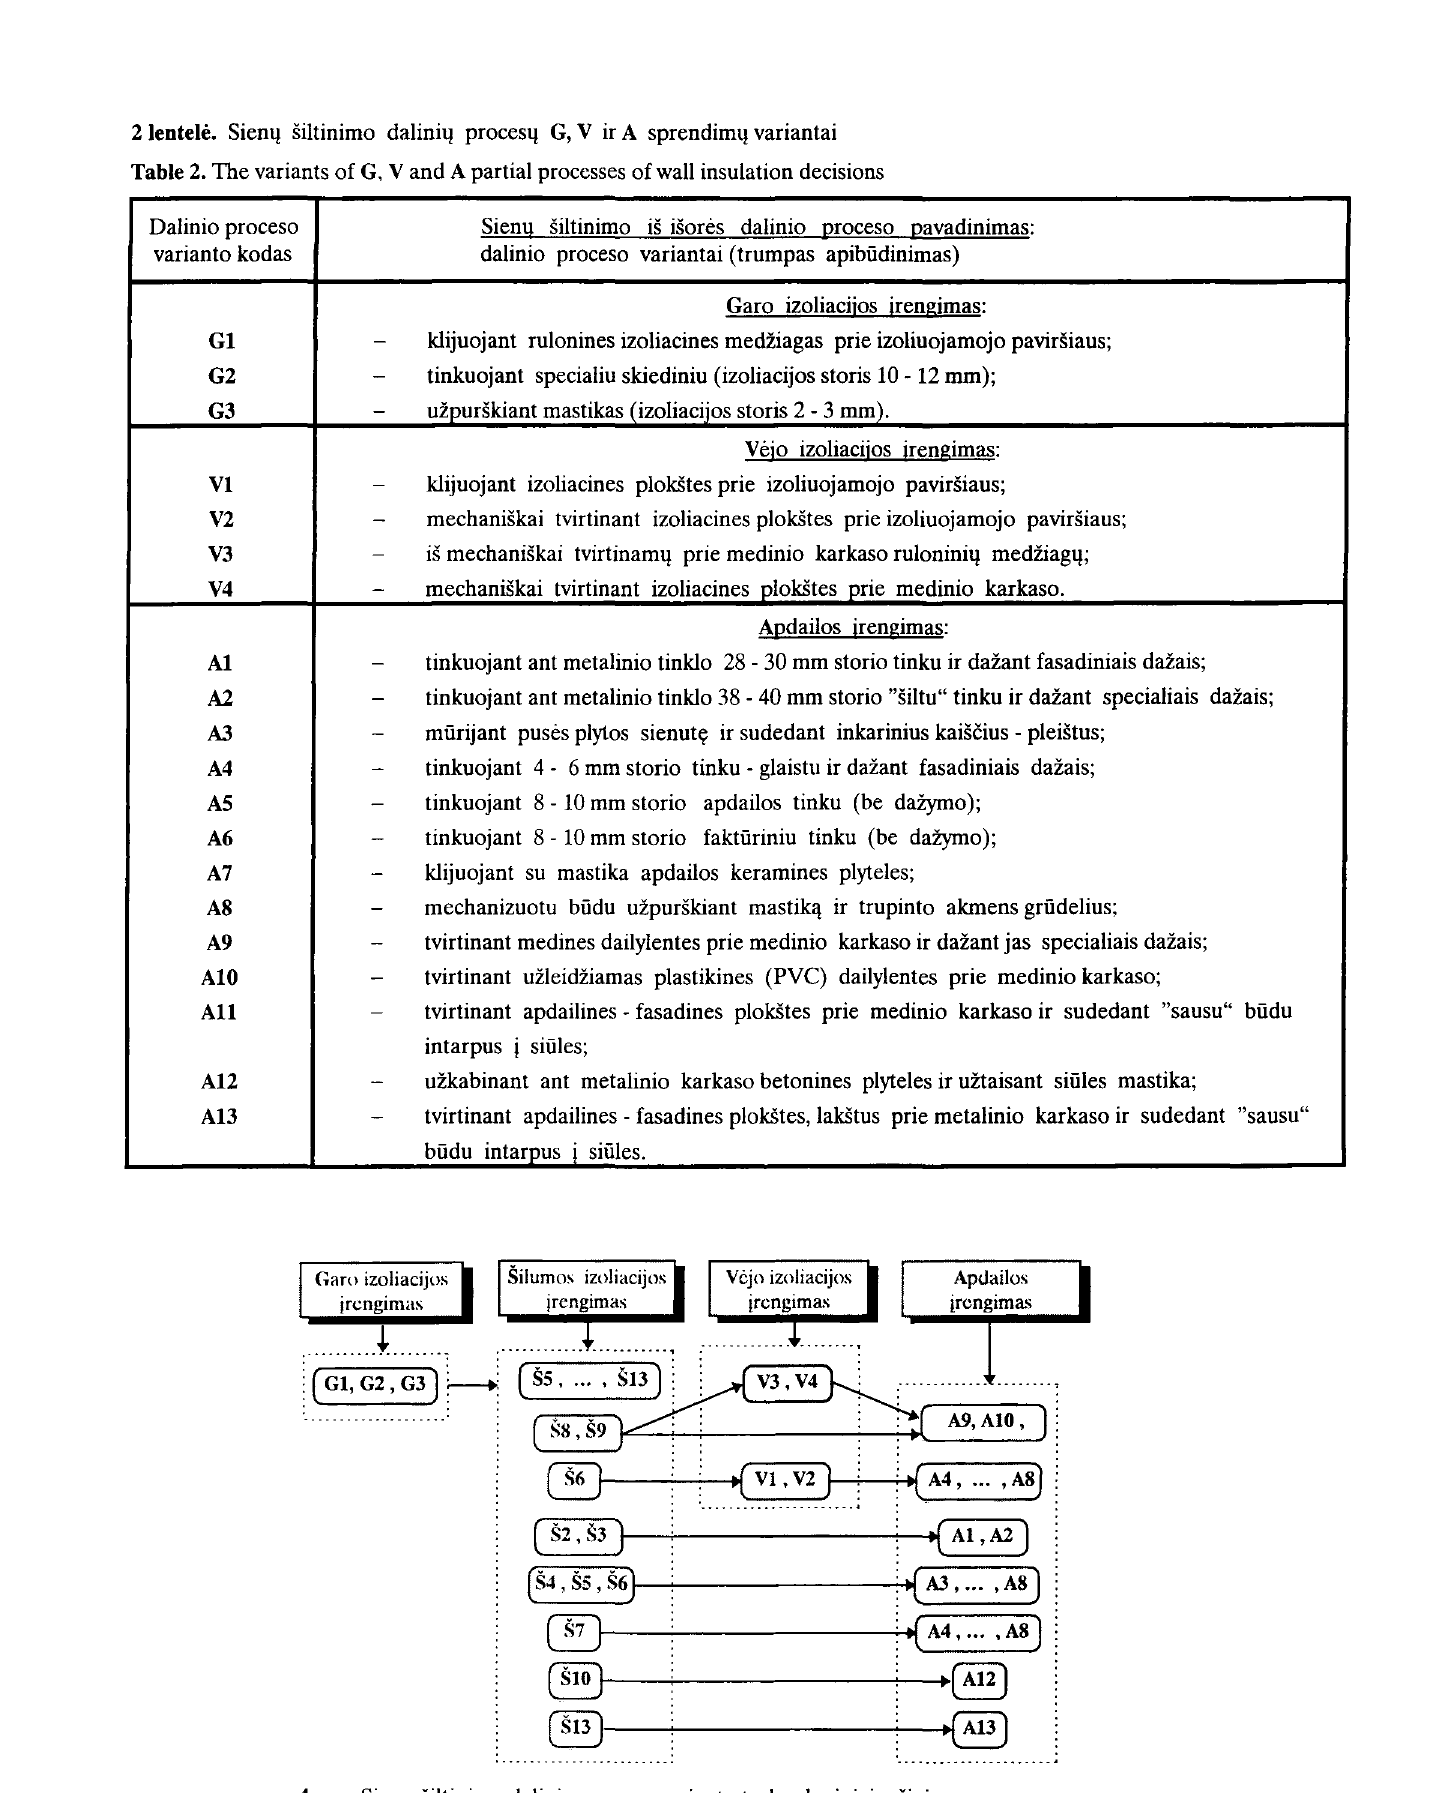
Fig 4. The technological relations of variants of partial wall insulation